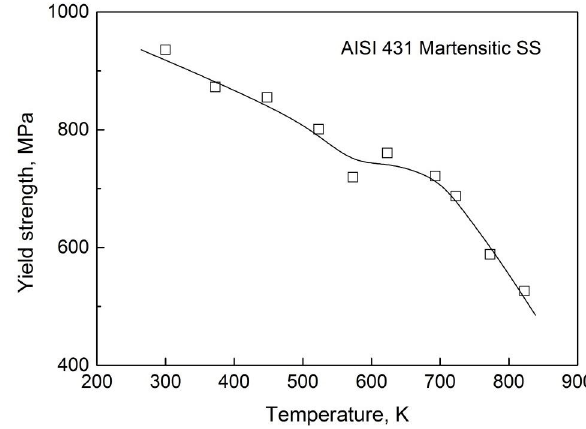
Figure 2: Variation of yield strength with temperature for the AISI 431